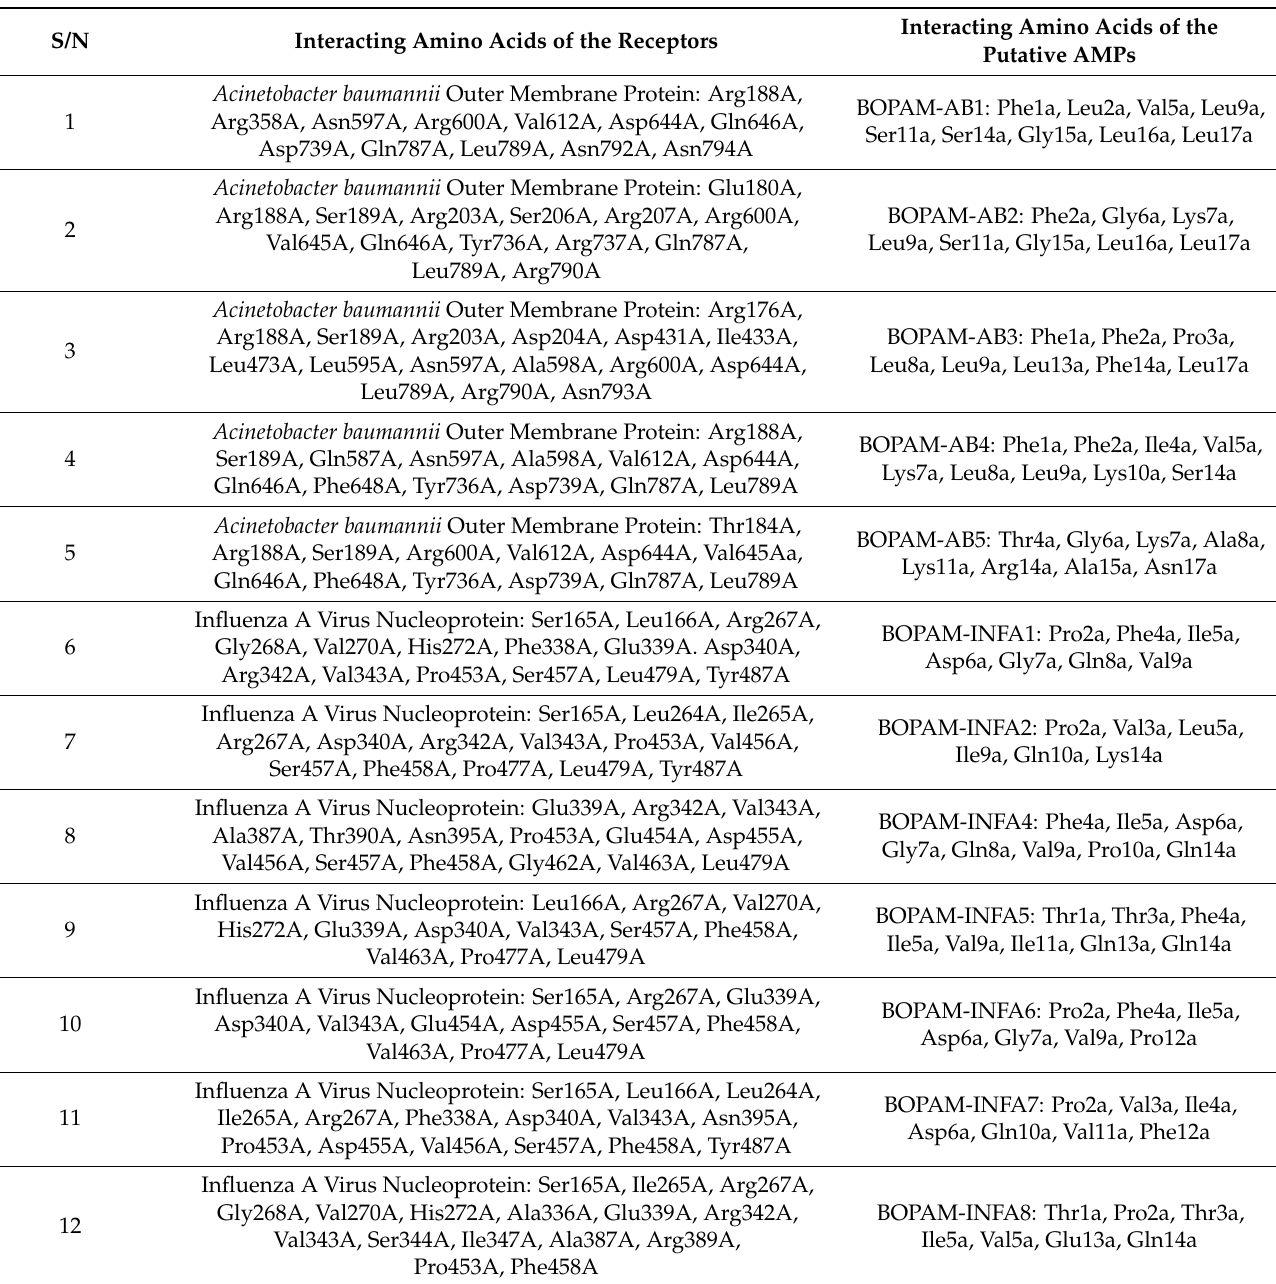
Table 1. Identification of mutation-sensitive amino acid residue hotspots using